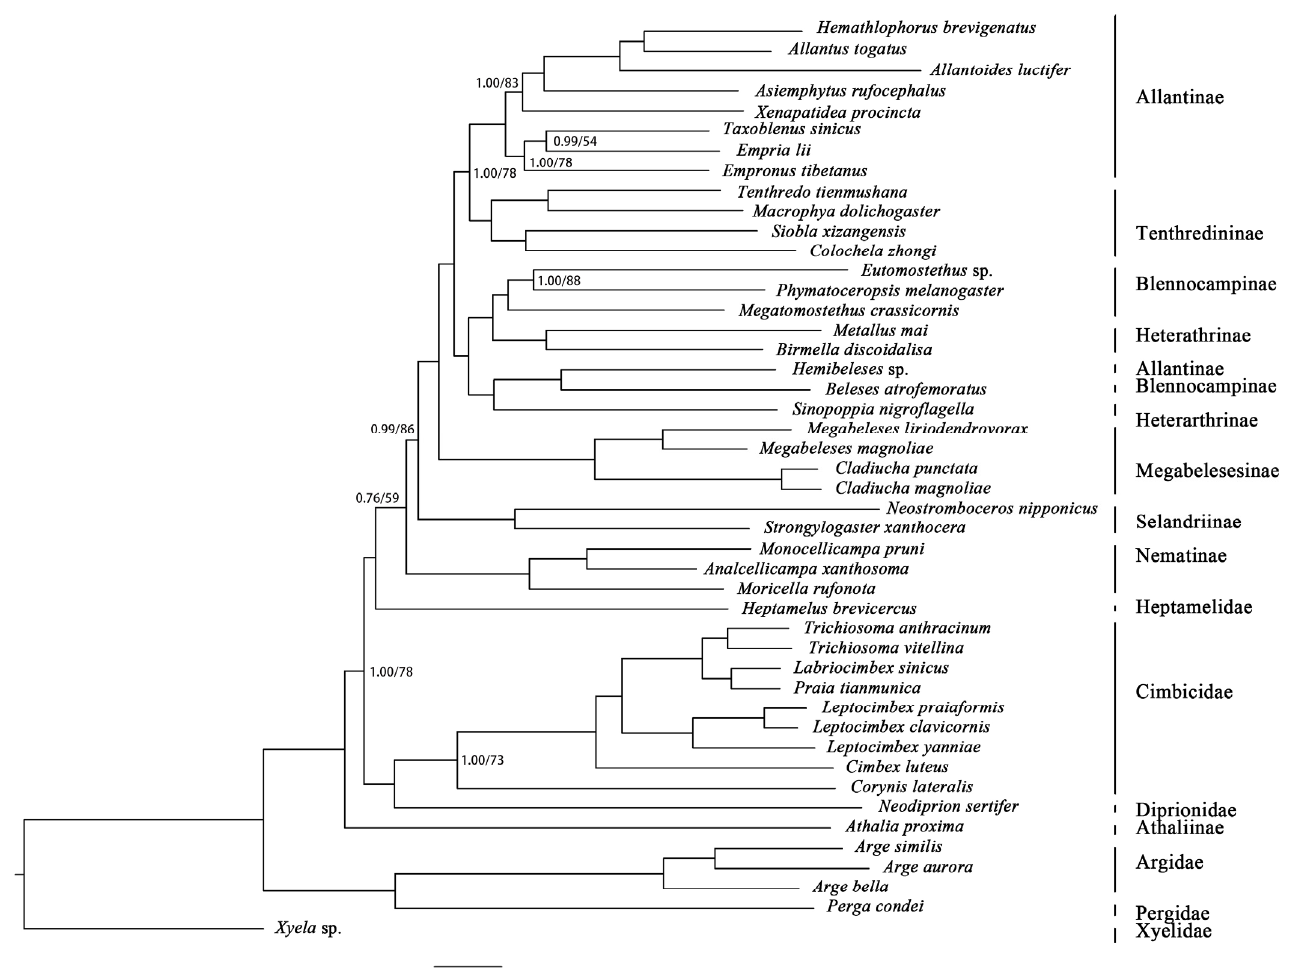
Figure 6. Phylogenetic tree recovered using the dataset P123RNA using Bayesian inference and maximum likelihood methods. Only support values <1.0 (posterior probabilities) and <100% (bootstraps) are shown.